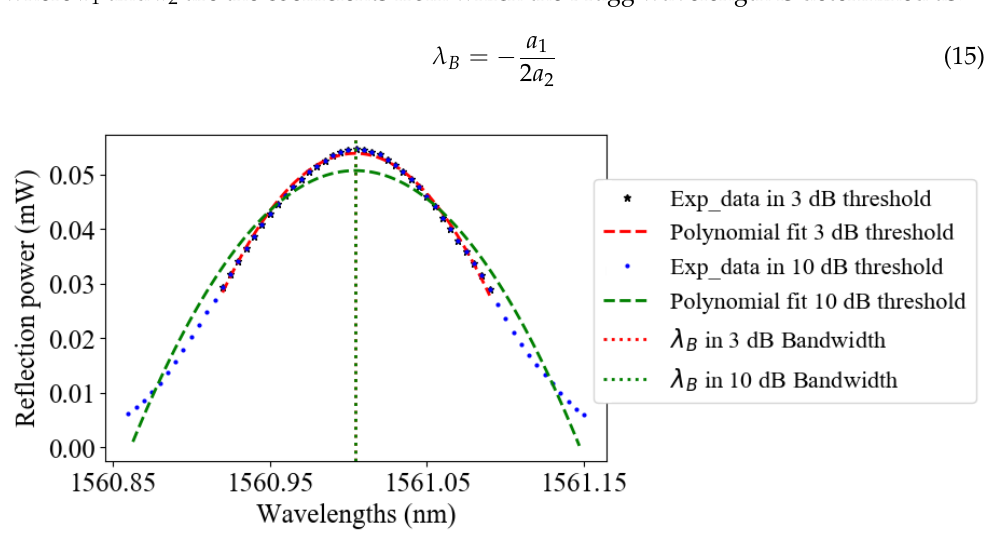
Figure 6. A second-order polynomial fit for linear scaled data points in 3 and 10dB